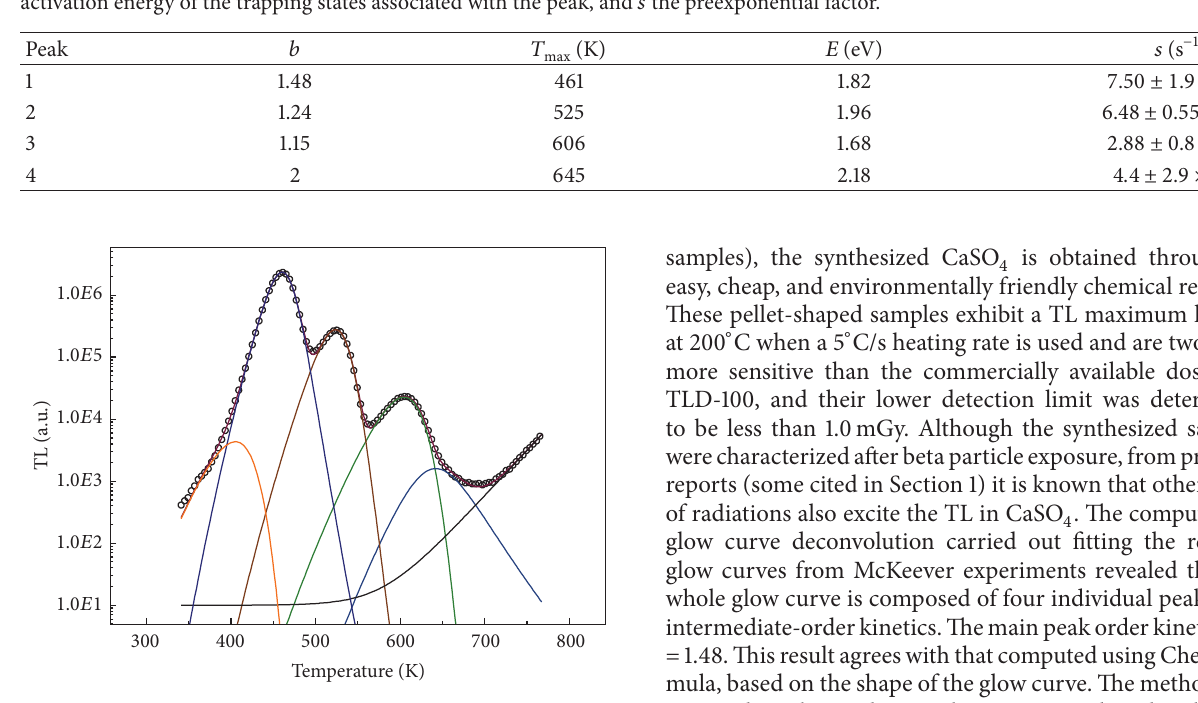
Figure 11: Glow curve of CaSO 4 :Eu resolved into individual TL peaks by glow curve deconvolution (GCD)